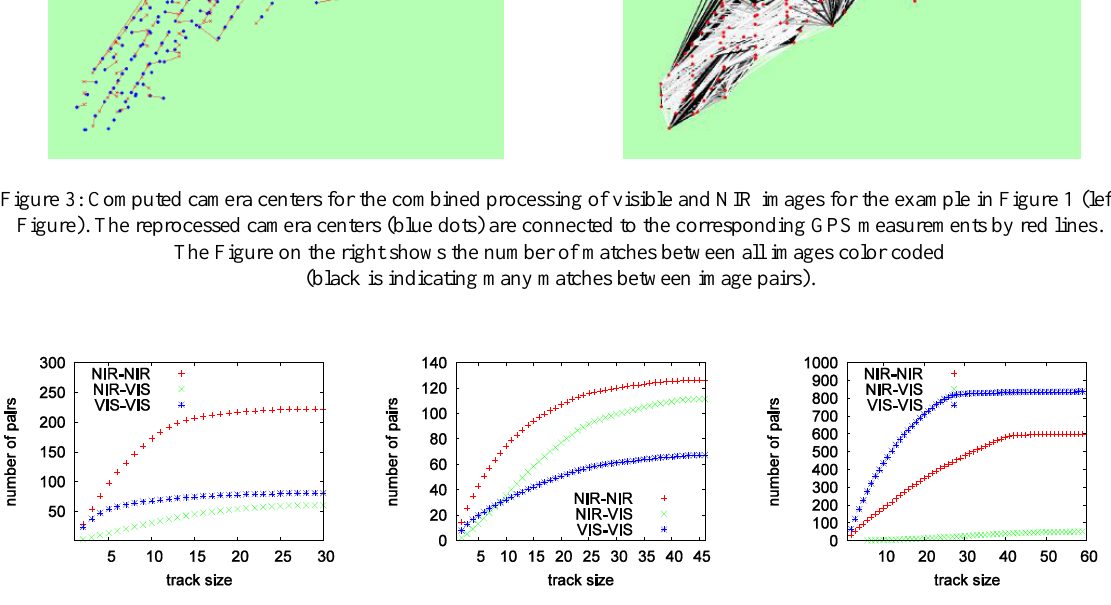
Figure 4. Matching statistics for NIR-NIR, NIR-visible and visible-visible image pairs for two different datasets. The figures contain cumulative number of matches as a function of the track size.